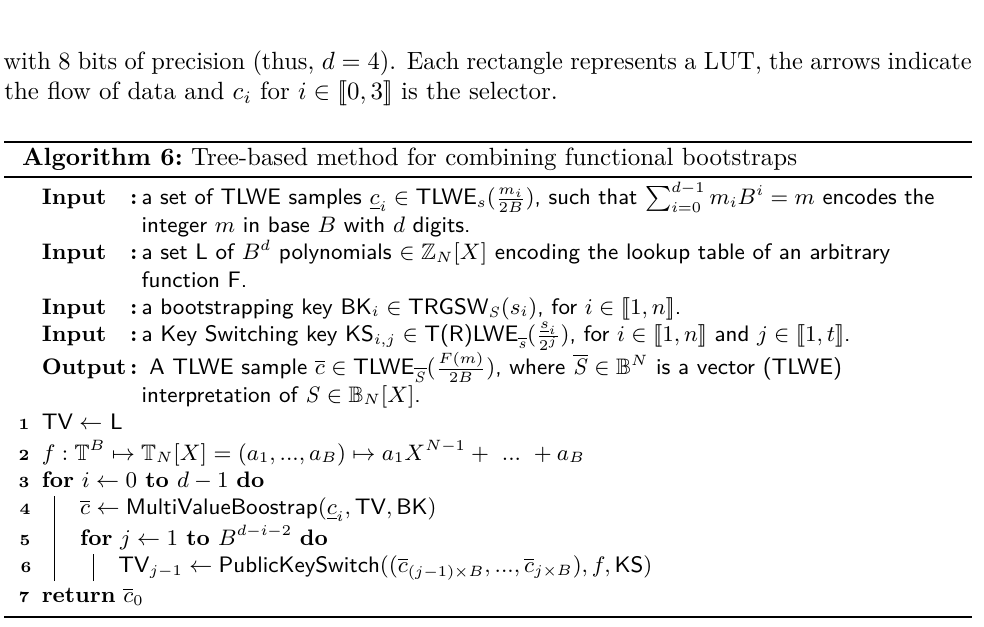
Figure 1: Evaluation of an 8-bit parity function using the tree-based and the chaining methods using base B = 4.